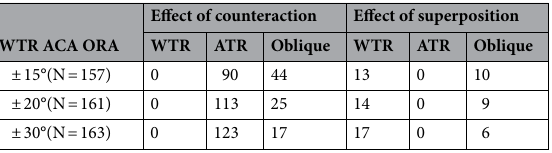
Table 3. The effect of ORA on with-the-rule ACA with different classification standards.